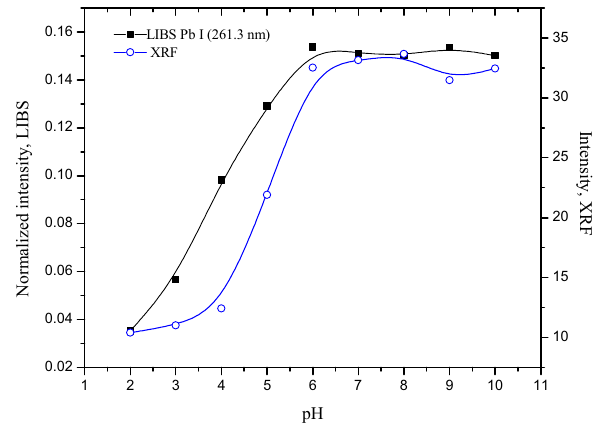
Fig. 4 Effect of pH on Pb (II) adsorption on nano- CaCO concentration of 1500 ppm evaluated using LIBS and pXRF